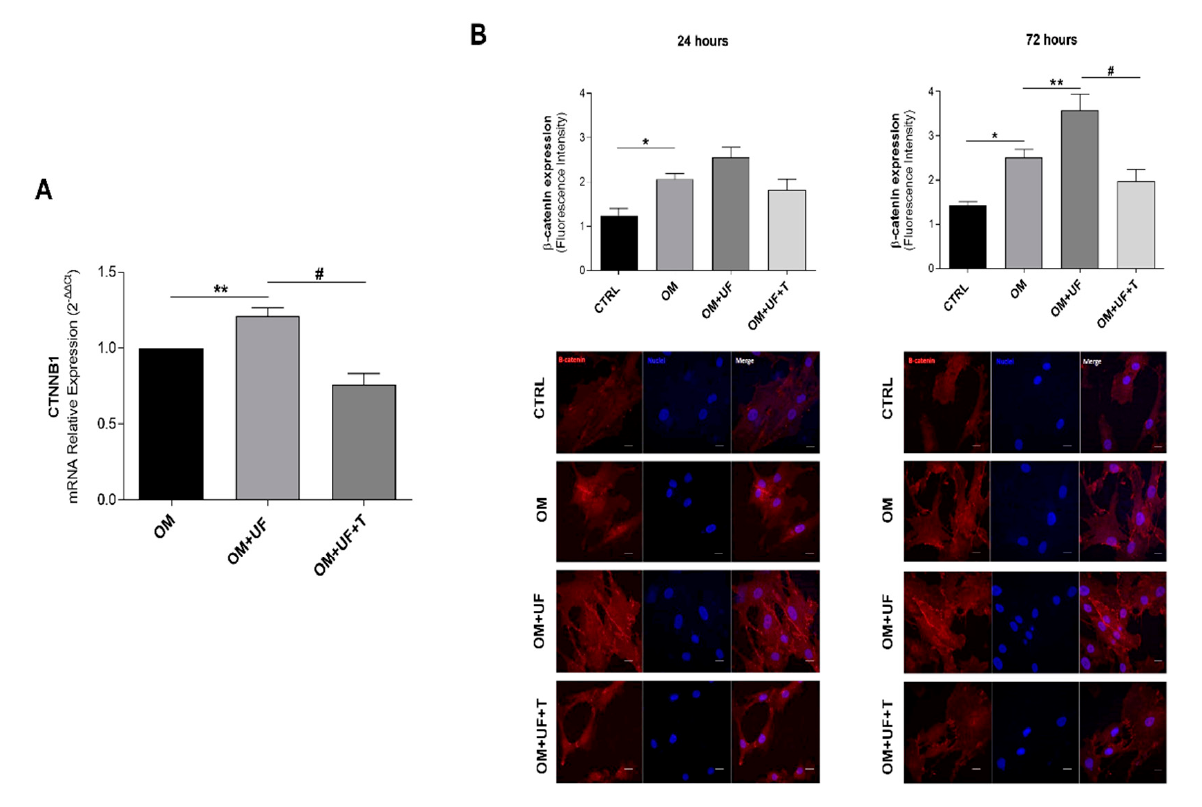
Figure 5. Effect of UF treatment on β -catenin expression: Effects of UF treatment on the ( A ) mRNA expression and ( B ) protein expression of β -catenin, analyzed by RT-PCR (CTNBB1) and immunofluorescence, respectively. Results are shown as the mean ± standard error (SEM) ( n ≥ 3); * p < 0.05 vs. CTRL; ** p < 0.05 vs. OM; # p < 0.05 vs. OM + UF + T (10 μ M).